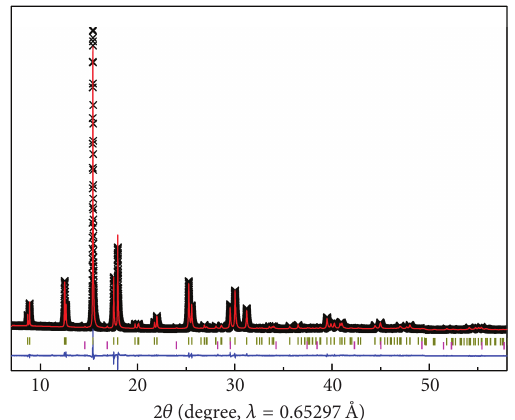
F 1: Rietveld re�nement of the synchrotron XRD pattern of SbN. e crosses and solid lines represent the observed and Mn calculated pro�les, respectively, and the difference between the 3 curves is shown at the bottom. Bragg positions are marked by small ticks (upper: Mn3ZnN, lower: MnO).